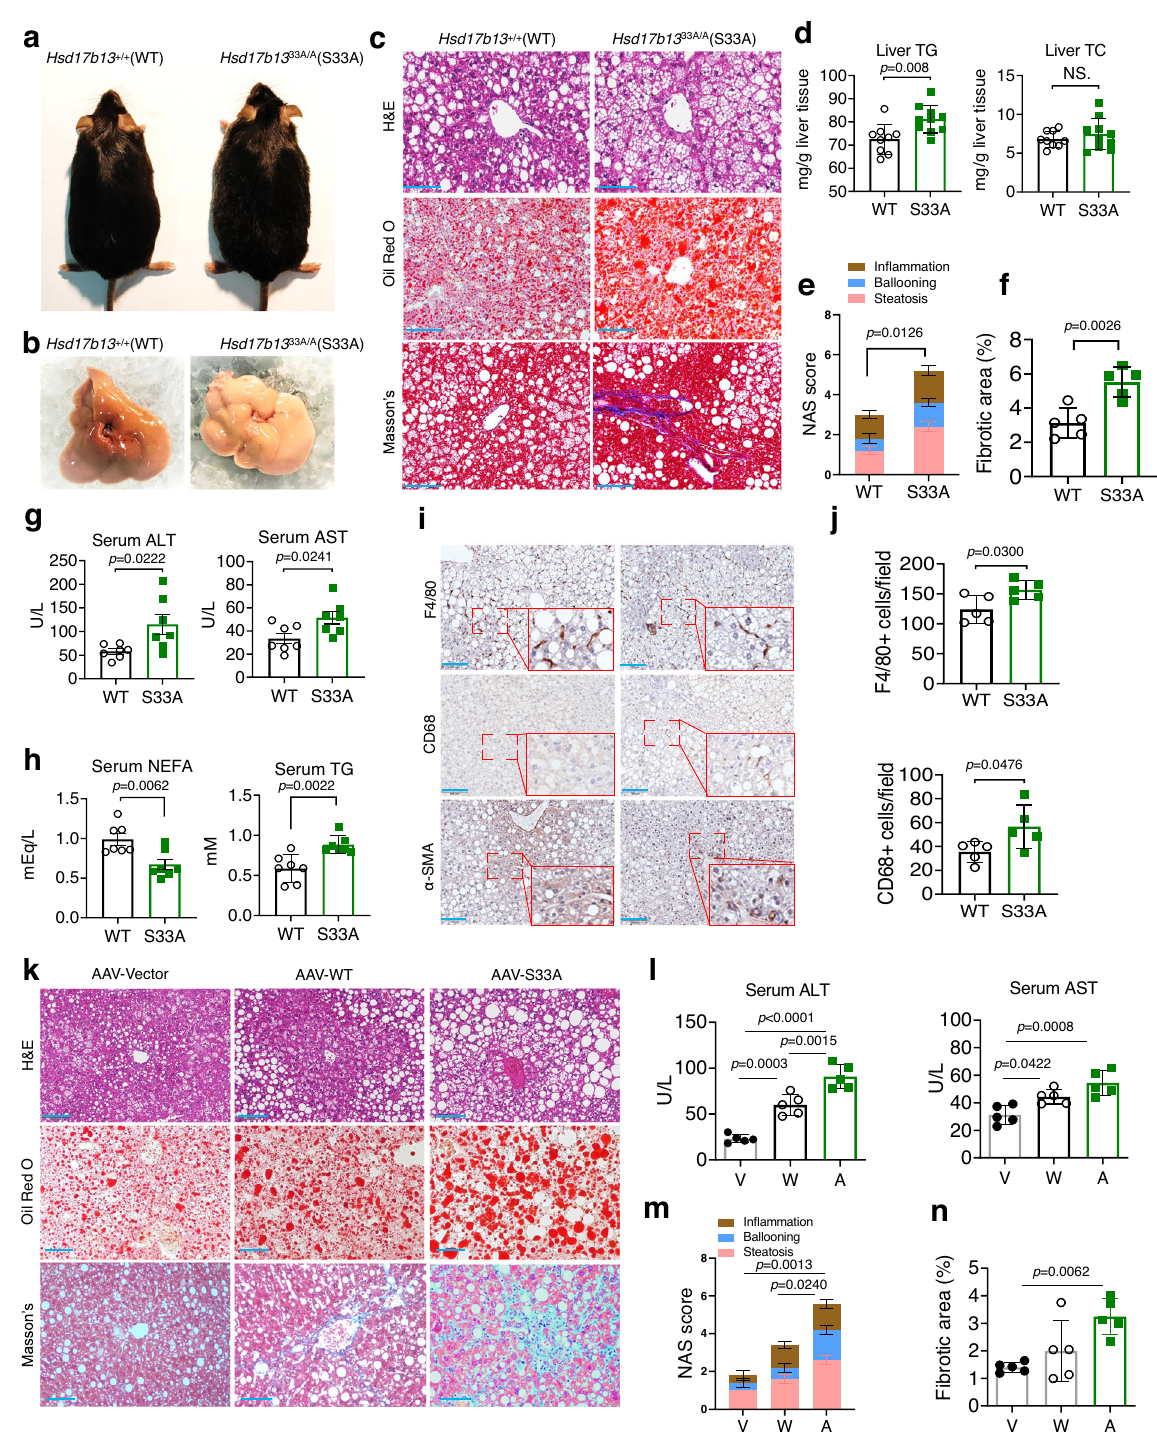
fi broticmarker( α -SMA)( i ).Thesemi-quanti fi cationdataofF4/80andCD68( j ).WT: n =5; S33A: n =5 biologically independent animals. k – n Global Hsd17b13 gene de fi cientmice(KO)werefed with aHFD for 3months.Atthe end of second month with HFD, an AAV9 empty vector (AAV-vector, v), an AAV carrying a full-length of WT17 β -HSD13(AAV-WT,WT)ortheS33Amutant(AAV-S33A,S33A)wasinjectedvia the tail vein. Representative liver H&E staining, Oil red O staining and Masson ’ s staining were displayed ( k ). Serum ALT and AST levels ( l ), the NAS score ( m ) and hepatic fi brotic area (%) ( n ) of mice were analyzed. AAV-V: n =5; AAV-WT: n =5; AAV-S33A: n =5 biologically independent animals. Data represent mean±SEM; Two-tailed student ’ s t test was performed for d – h , ( j ); One-way ANOVA with Bon- ferroni post hoc analysis was performed for l – n